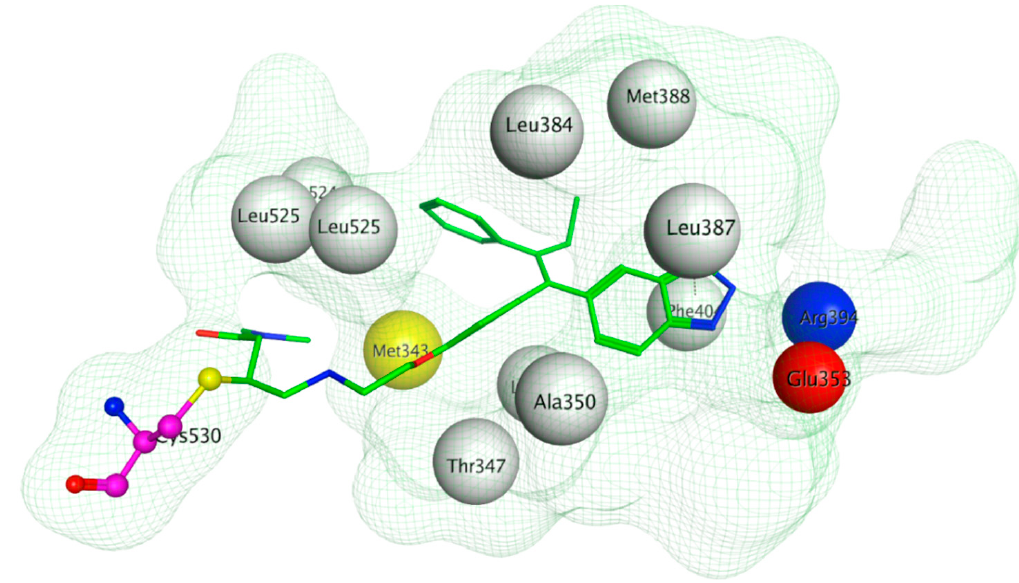
Figure 13. Site view of H3B-5942 (green) in complex with ER α -EBS. It forms a covalent bond with the residue Cys530 shown in pink (pdb: 6CHW).